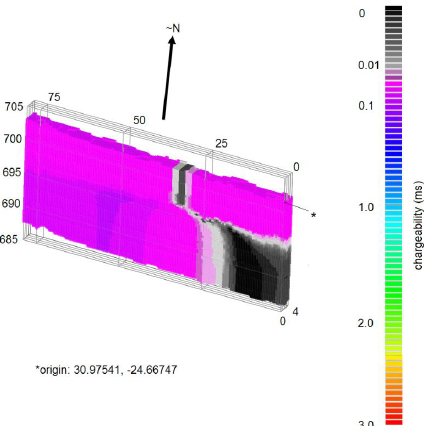
Fig. 11. Pseudo 3-D IP section of the SW–NE parallel transects. Scales are in metres diverging from a geographical origin, vertical scale is altitude a.s.l. (Wenner long, 2m spacing, 6th iteration, RMS error 13.3%).